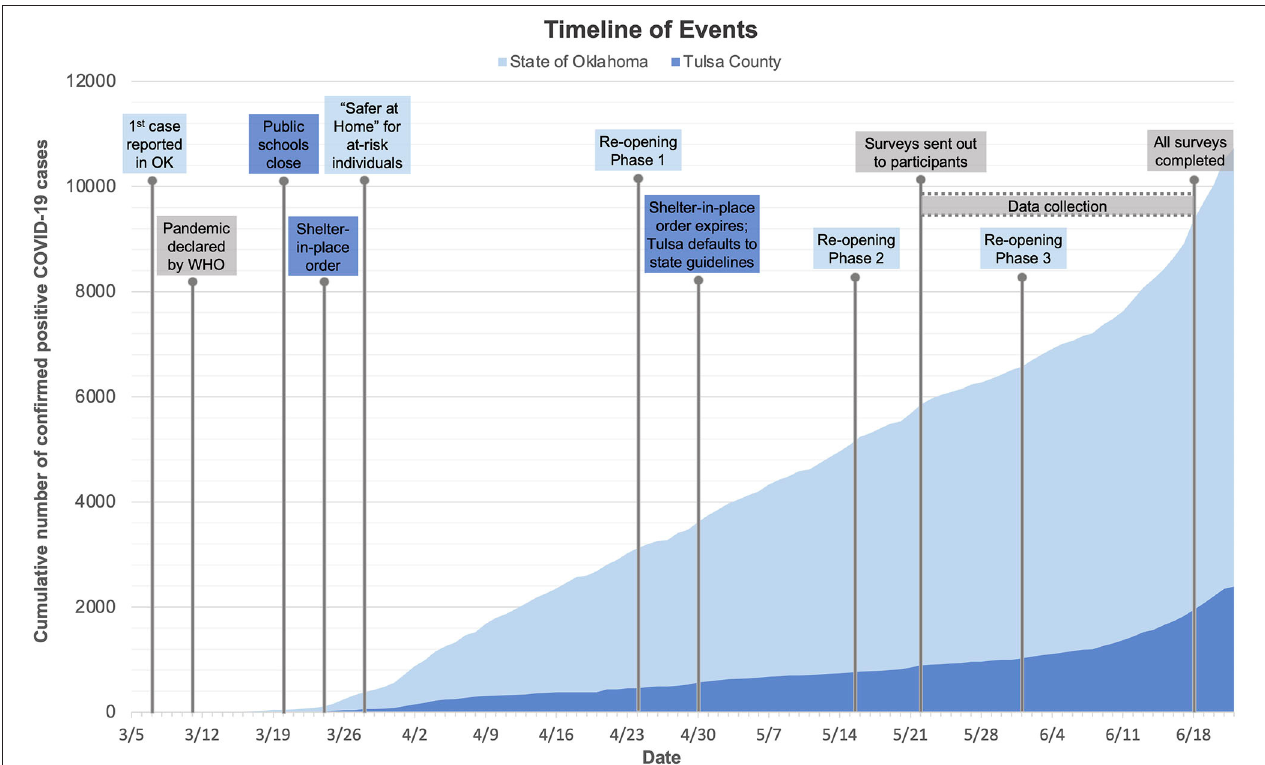
FIGURE 1 | A timeline of state and local government restrictions and the trajectory of total cases. Between the pre-pandemic baseline and the COVID-19 follow-up assessment, participants had experienced the onset of the pandemic, a shelter-in-place order, rising rates of local cases, and a push toward reopening.